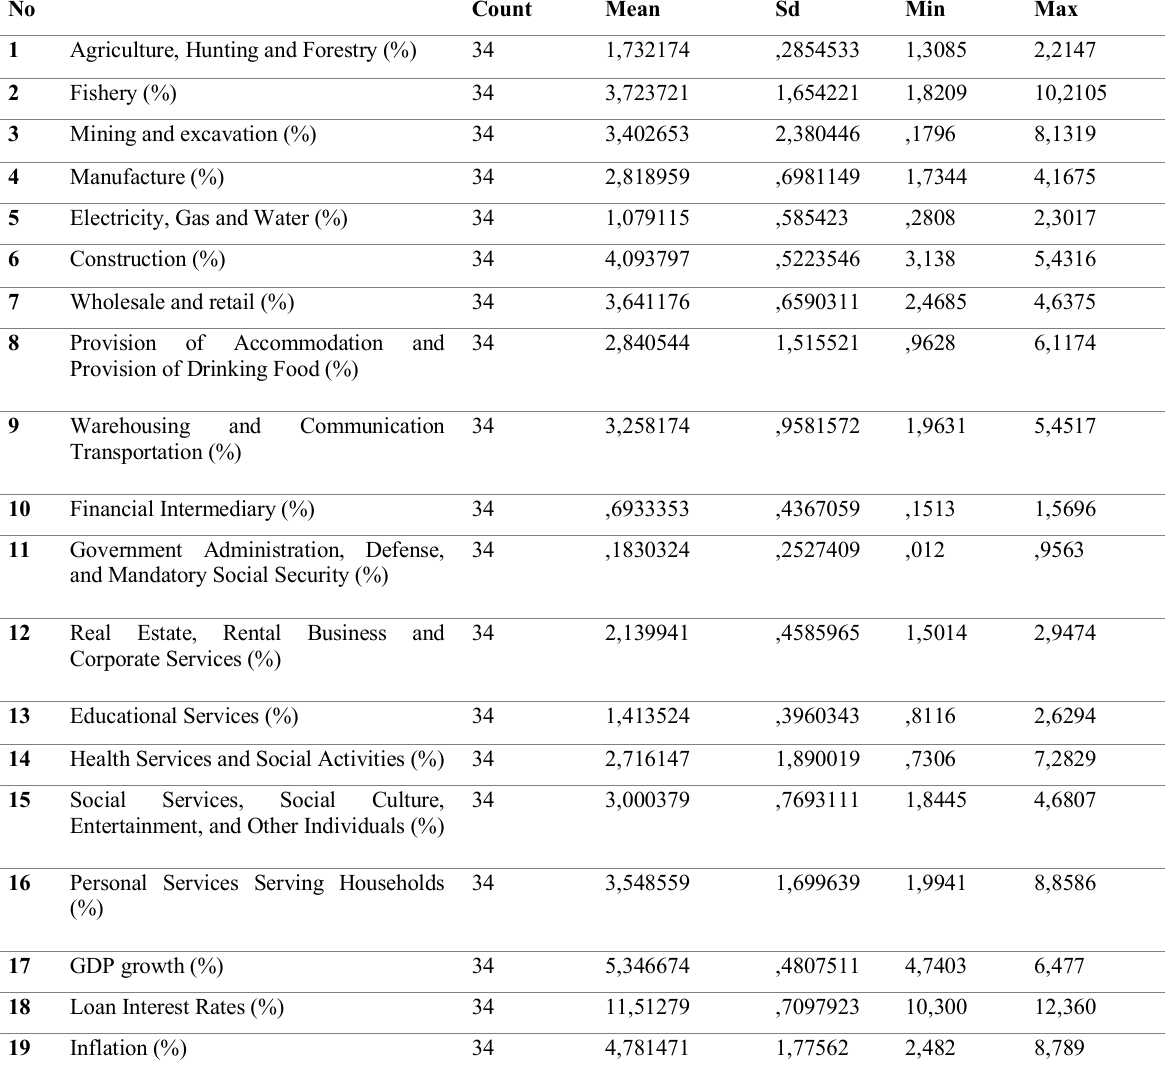
Table 1 : Summary of Descriptive Statistics of